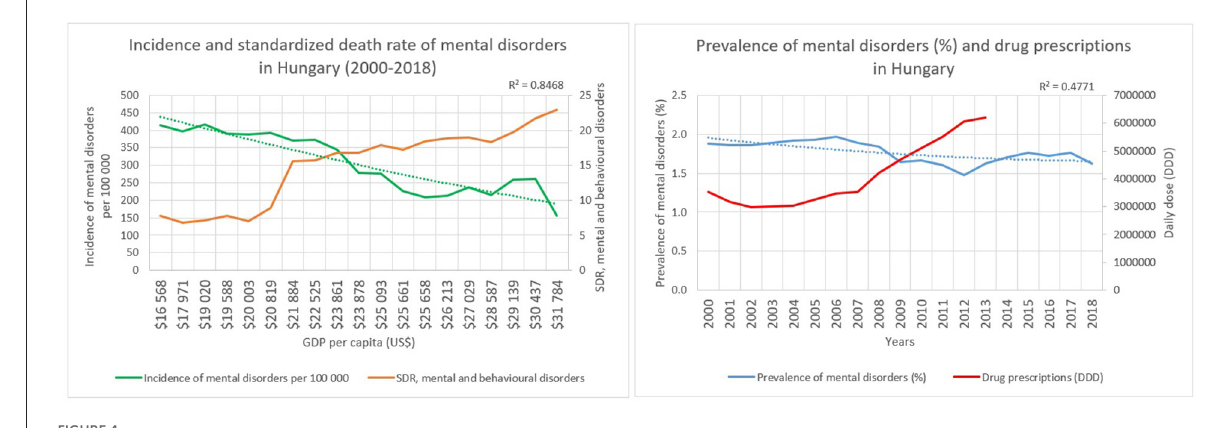
FIGURE4 Characteristics of